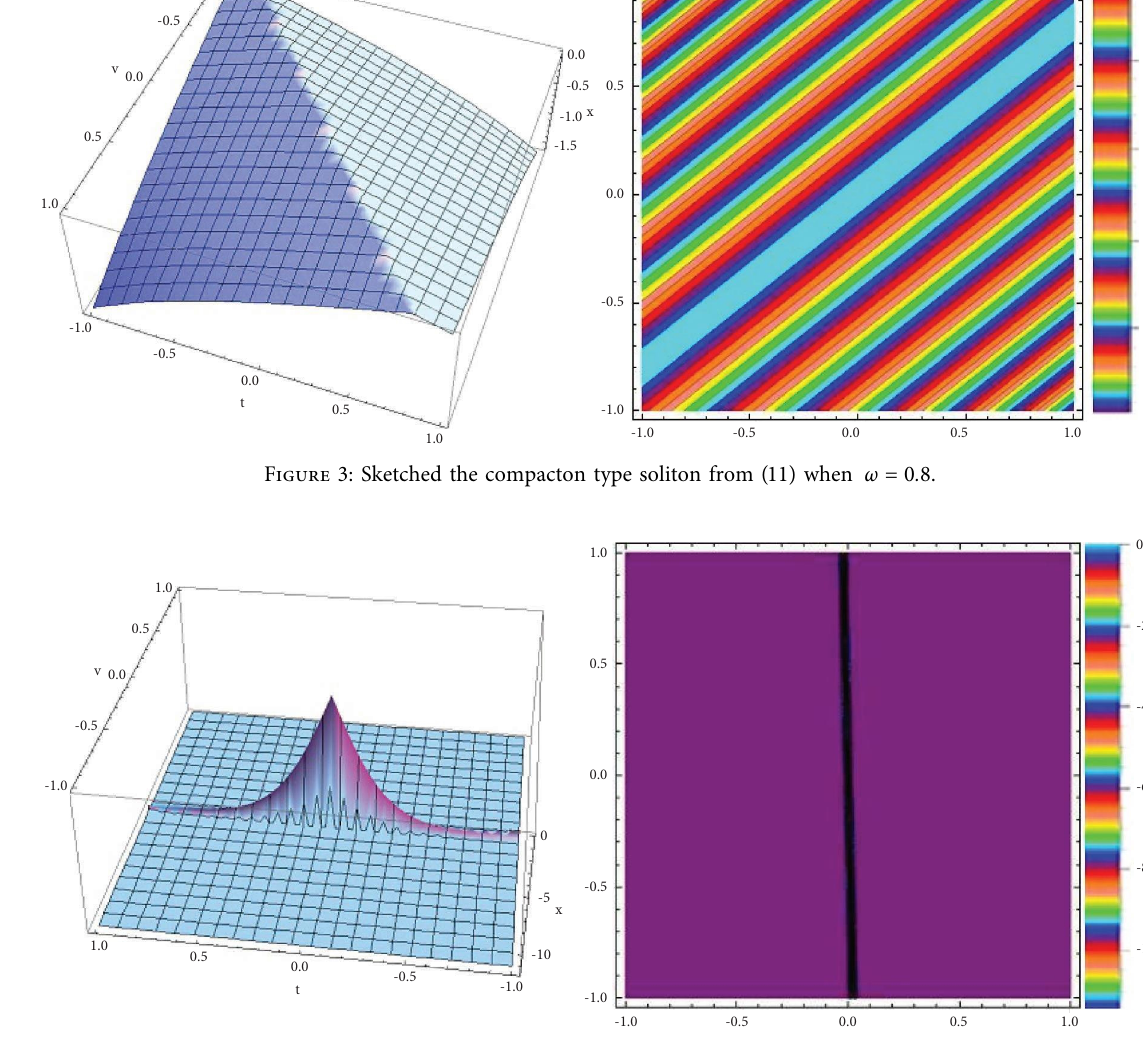
Figure 4: Design3D and contour shape of (13) for ω � 44 . 53.